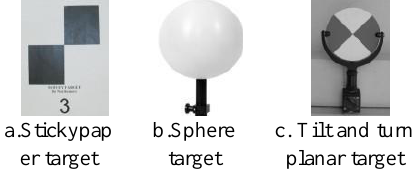
Figure 3. Different types of